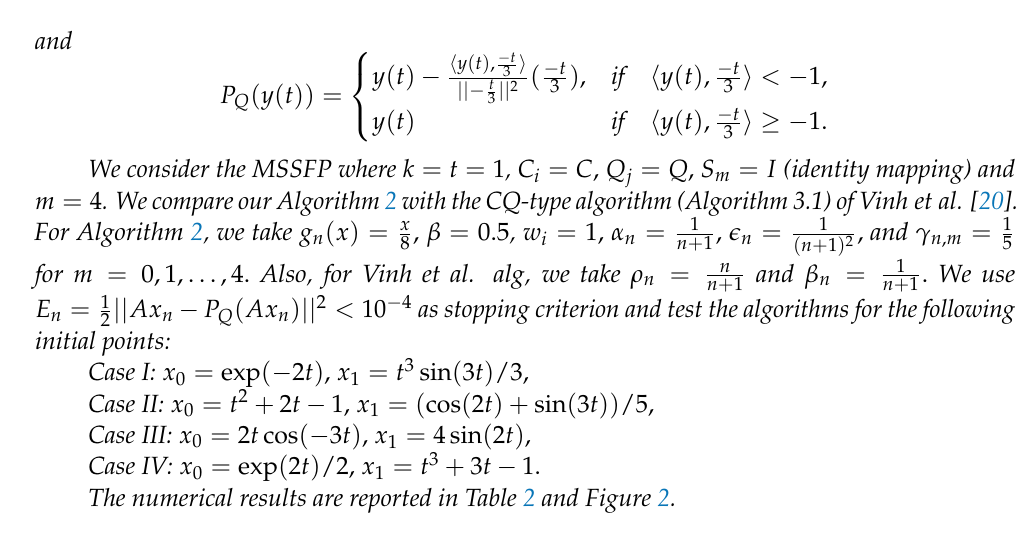
Table 2. Computation result for Example